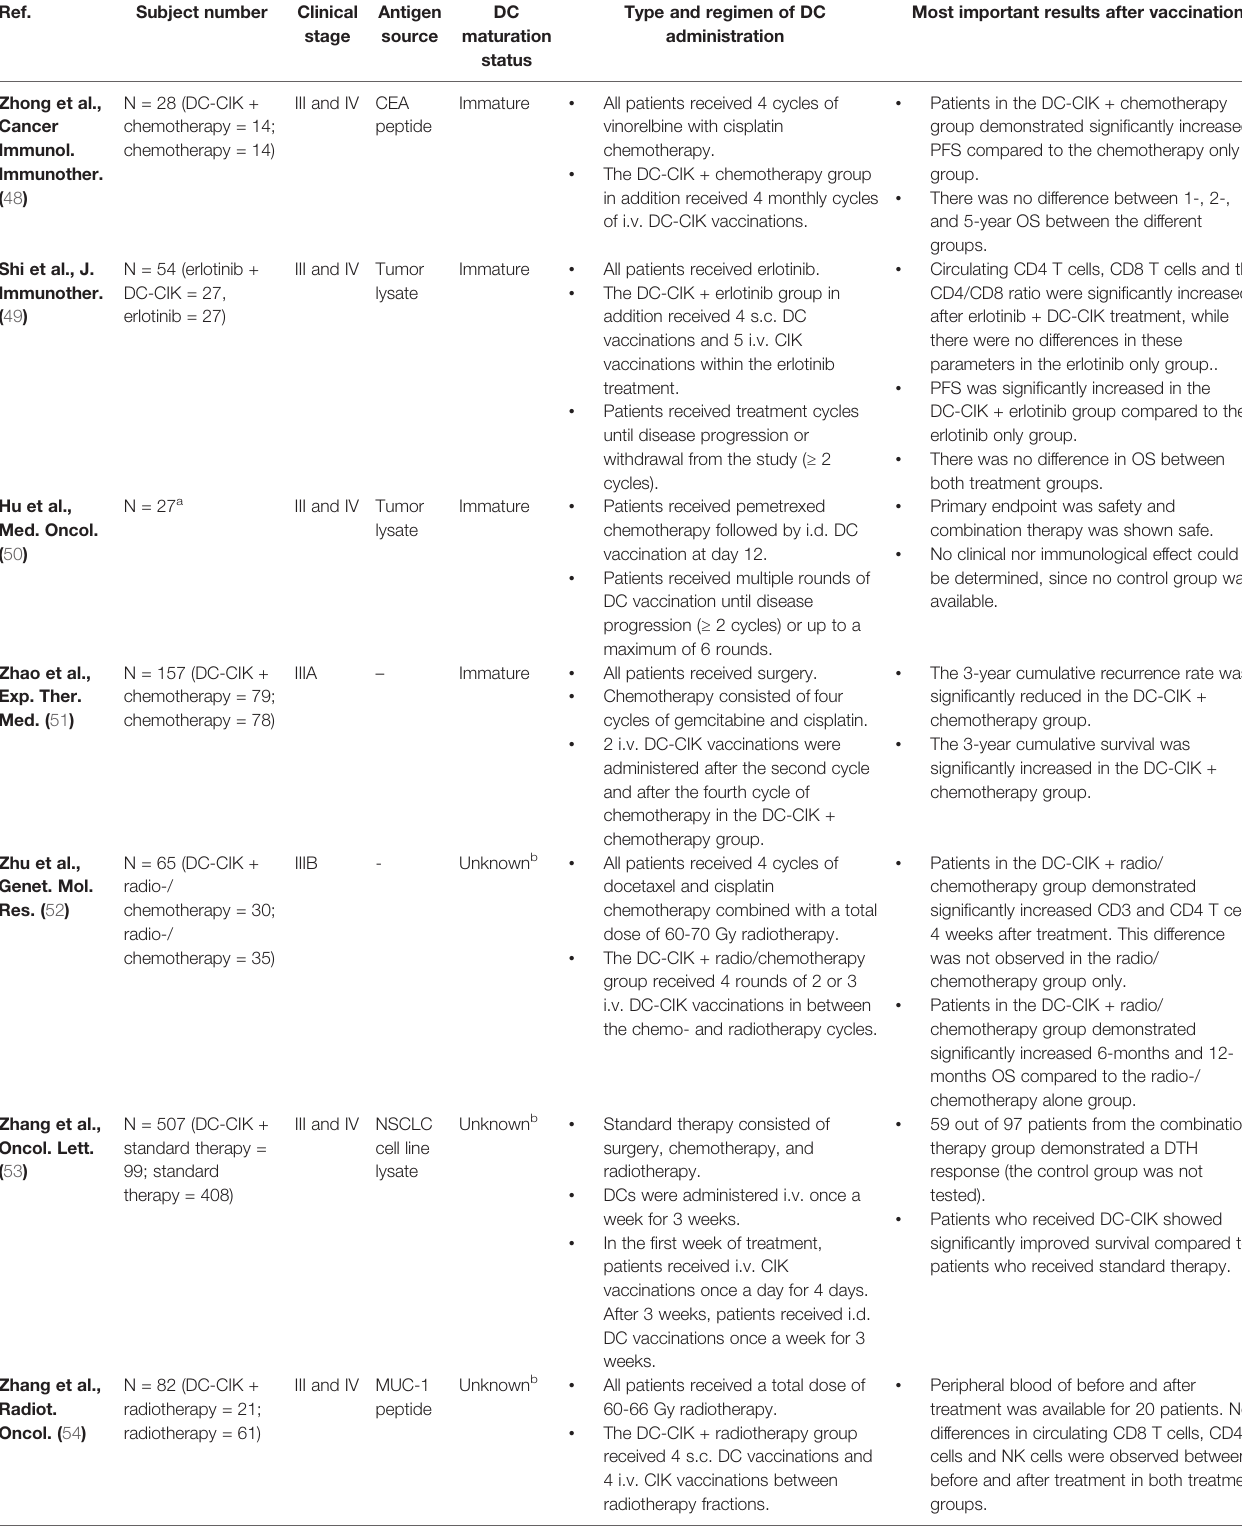
TABLE 2 | Characteristics of studies in which DC vaccination combination therapy was performed in NSCLC.